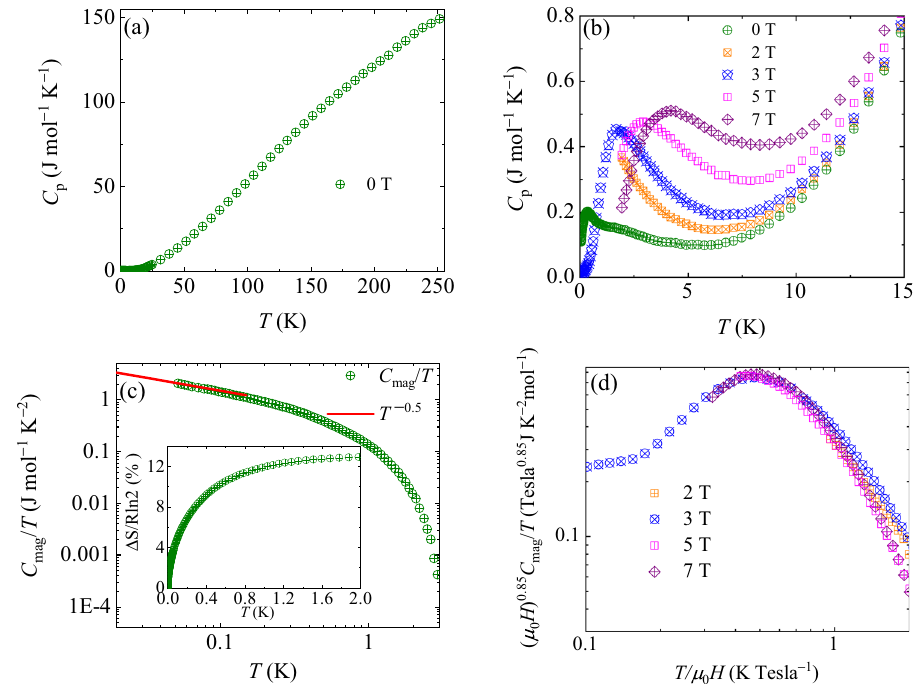
Fig. 3 Speci fi c heat measurements reveal a randomness-induced spin-liquid state in Li 4 CuTeO 6 . a The temperature dependence of the speci fi c heat ( C p ) in zero magnetic fi eld in a broad temperature range 0.052 K ≤ T ≤ 250 K. b The temperature-dependent speci fi c heat in different magnetic fi elds upto 7 T. c The temperature dependence of magnetic-speci fi c heat divided by temperature in zero fi eld in a log-log scale where the red line is the power-law fi t. Inset shows the temperature dependence of associated entropy change. d The scaling behavior of the magnetic-speci fi c heat with C mag ð μ of the scaled temperature T / μ 0 H for several fi